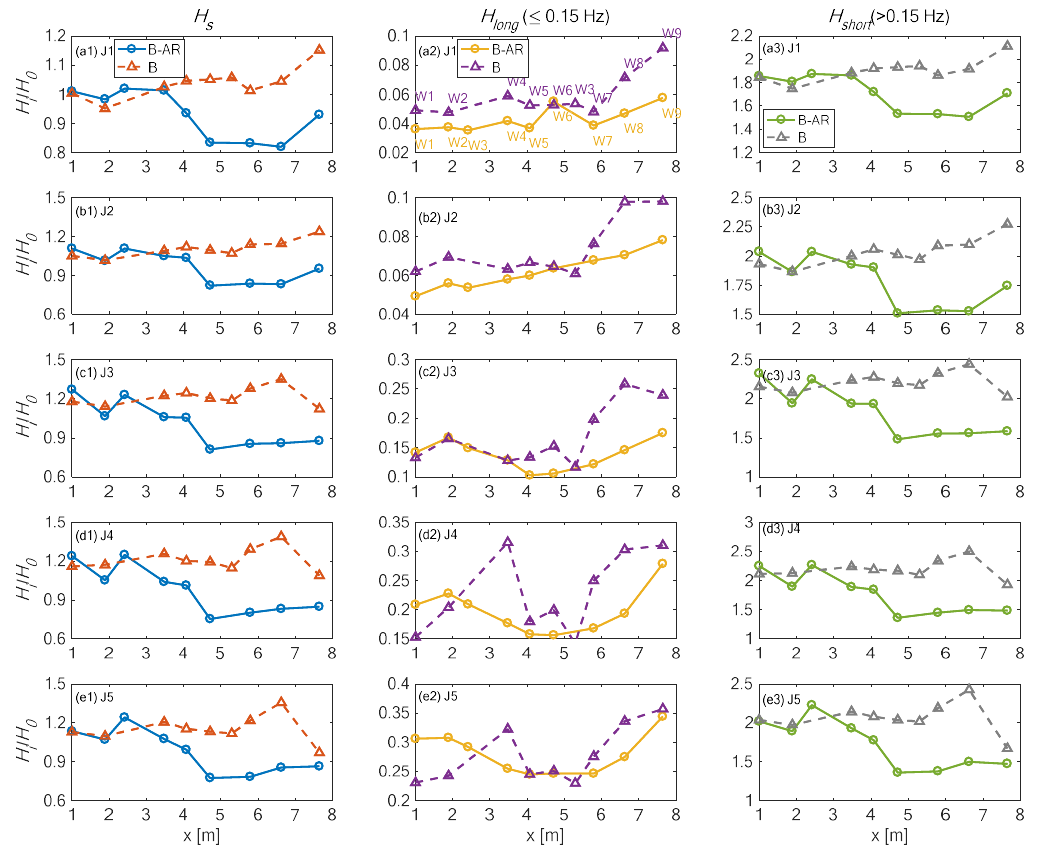
Figure 8. The cross-shore distribution of characteristic wave height ( H i ) relative to the incident ( H 0 ) in irregular wave tests (panels sorted by ( a – e ) indicate the wave conditions from J1 to J5; for a specific wave condition, three panels from left to right, numbered 1, 2, 3, show significant wave height, wave height of high and low frequency domains, respectively; H 0 is the model wave height in Table 1; W1–W9 are the wave gauges in Figure 2).